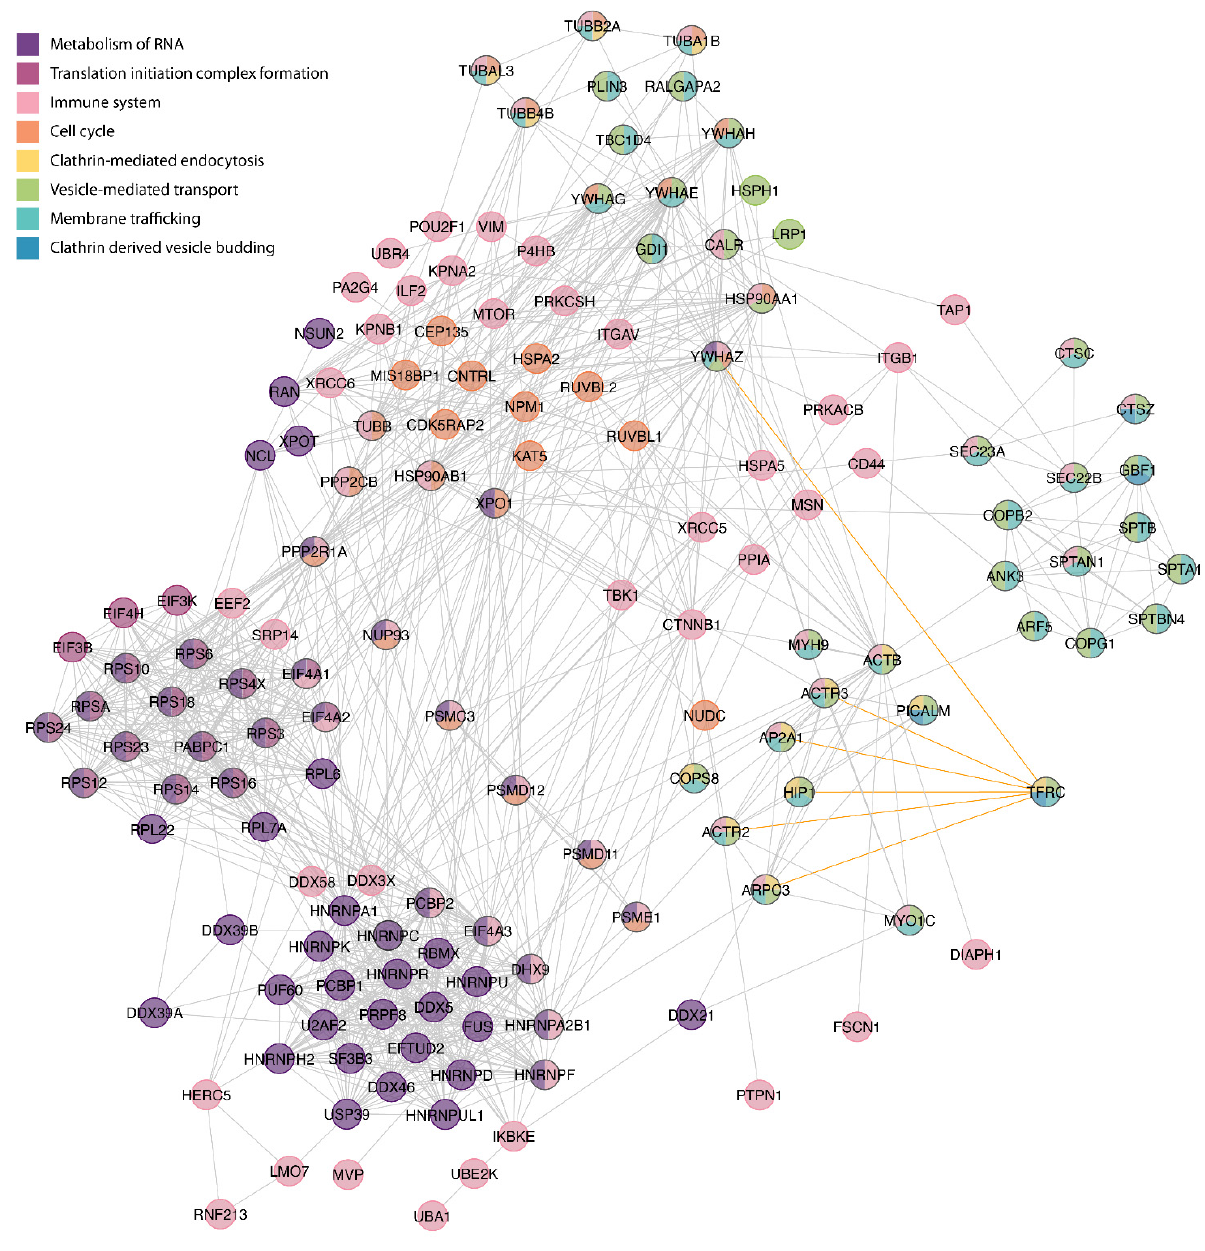
Figure 2. TfR1 (TFRC) proteins interactome. TfR1 can exert varied actions on important biological pathways within the cancer cells such as metabolism of RNA, translation initiation complex formation, immune system, cell cycle, clathrin-mediated endocytosis, vesicle-mediated transport, membrane trafficking, and clathrin-derived vesicle budding, mainly mediated by its direct interaction with dysregulated actin-related proteins and ubiquitous scaffolding proteins such as